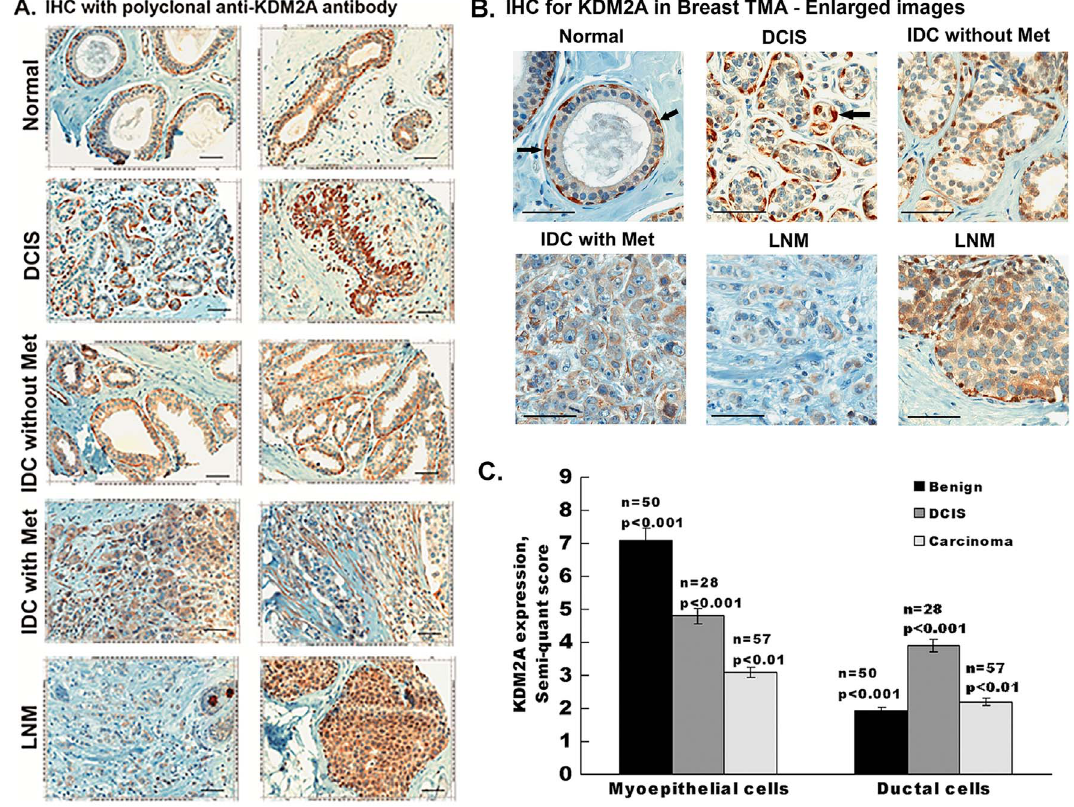
Figure 1. Myoepithelial cells of the breast express KDM2A. (A) Immunohistochemical staining of KDM2A on human breast cancer tissue microarray. Immunostaining was performed using rabbit anti-human KDM2A antibody and representative images of KDM2A expression in normal breast, Ductal Carcinoma in situ, Infiltrating Ductal Carcinoma with and without metastasis, lymph node metastasis are shown. Magnification is 200X, scale bar =50 m m. (B) Enlarged images of normal and cancer breast tissue sections. Arrows indicate positively stained myoepithelial cells. Scale bar =50 m m. (C) Quantitative analysis of KDM2A in breast tissue microarray. The Immunostaining of KDM2A was quantified by using semi quantitative scoring method based on cellularity and intensity of expression. The means of two independent arrays are shown. All p -values were calculated using a two-sided Student t- test.